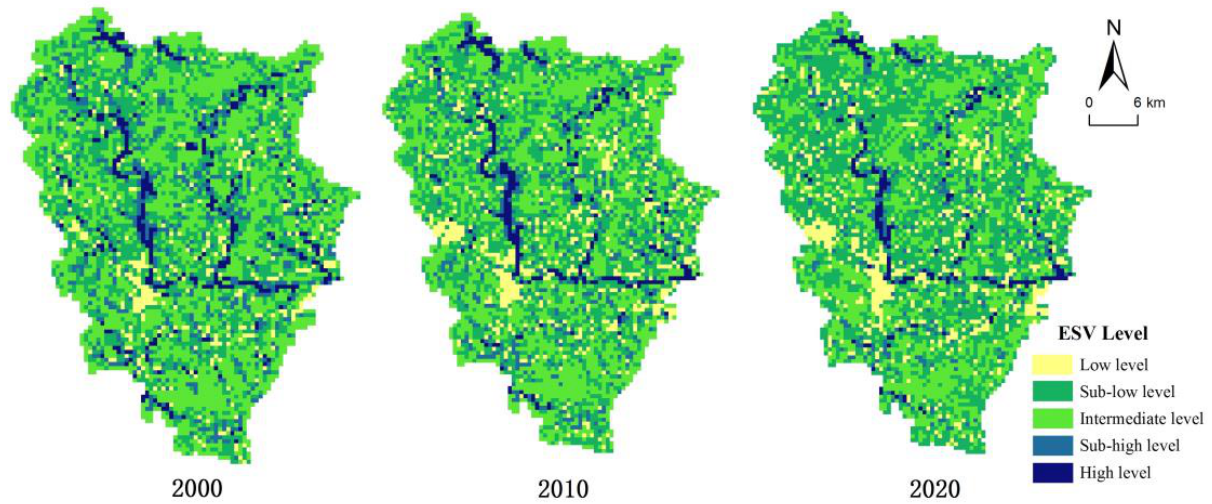
Figure 9. Spatial distribution of ESV levels.